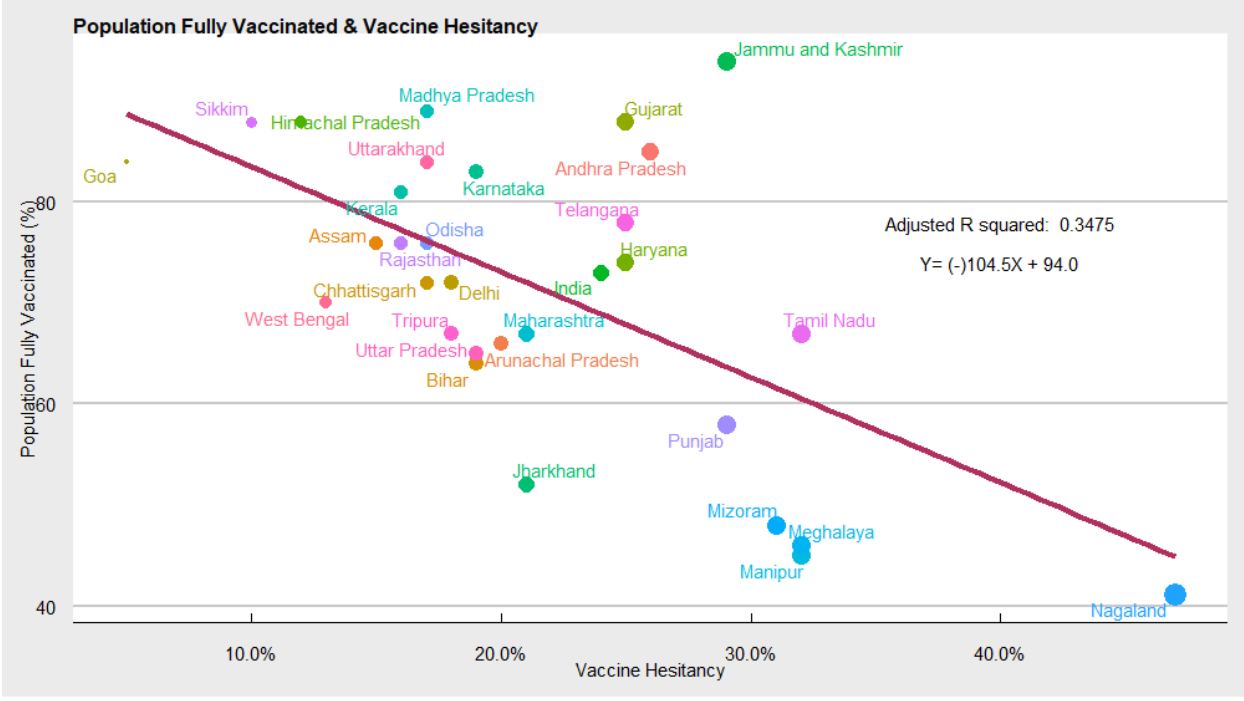
Figure 2. Scatter plot depicting COVID-19 vaccine hesitancy and vaccination